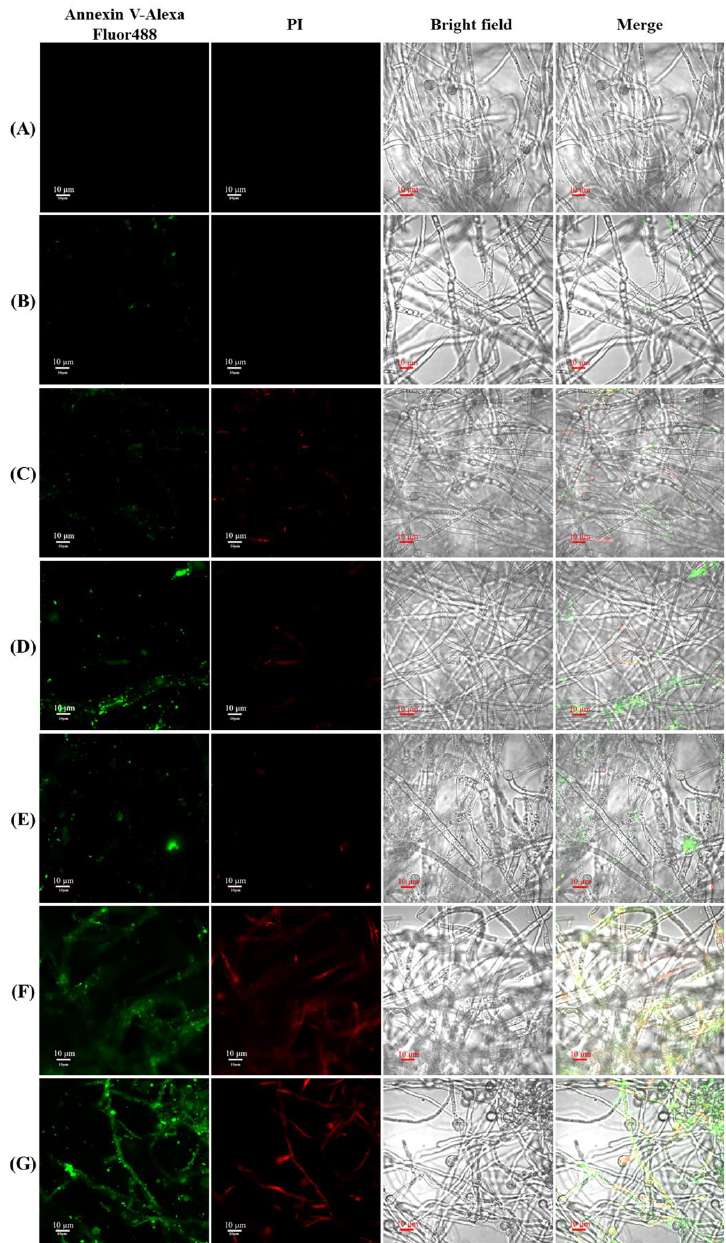
Figure 5. Effects of lemon essential oil nanoemulsion (LEO/NE) and equivalent wall material (Eq Wm) on cell apoptosis of Phomopsis sp. Apoptosis was observed using Annexin V − Alexa Fluor 488/PI staining. Fluor 488 positive (green) indicates cell undergone apoptosis. Fluor 488 positive and PI negative (red) indicates cell apoptosis at early stage. Double − positive staining indicates late apop- tosis or necrosis. ( A ), ( B ), ( C ), ( D ), ( E ), ( F ) and ( G ) was the double staining results of Blank, Eq Wm of 0.05%LEO/NE, Eq Wm of 0.1%LEO/NE, Eq Wm of 0.2%LEO/NE, 0.05%LEO/NE, 0.1%LEO/NE and 0.2%LEO/NE, respectively; ( B ) CAT activities; ( C ) SOD activities; ( D ) GSH − PX activities.